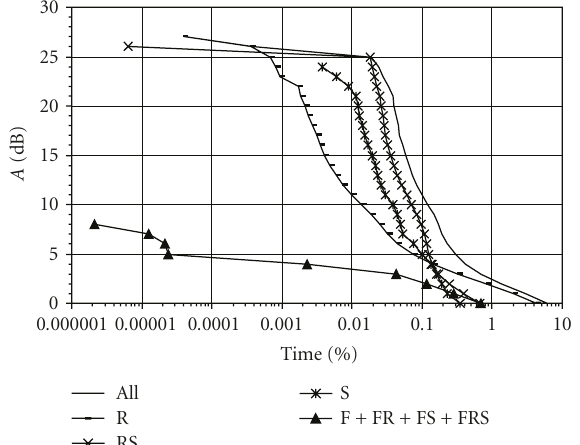
Figure 11: Obtained CDs of visibility due to all the fog events combined and to the individual fog events separately on the FSO path over the 6-year period of